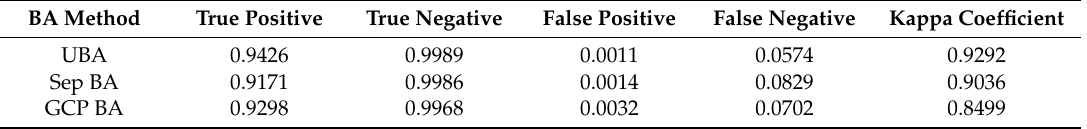
Table 2. Change detection accuracy comparison of three bundle adjustment